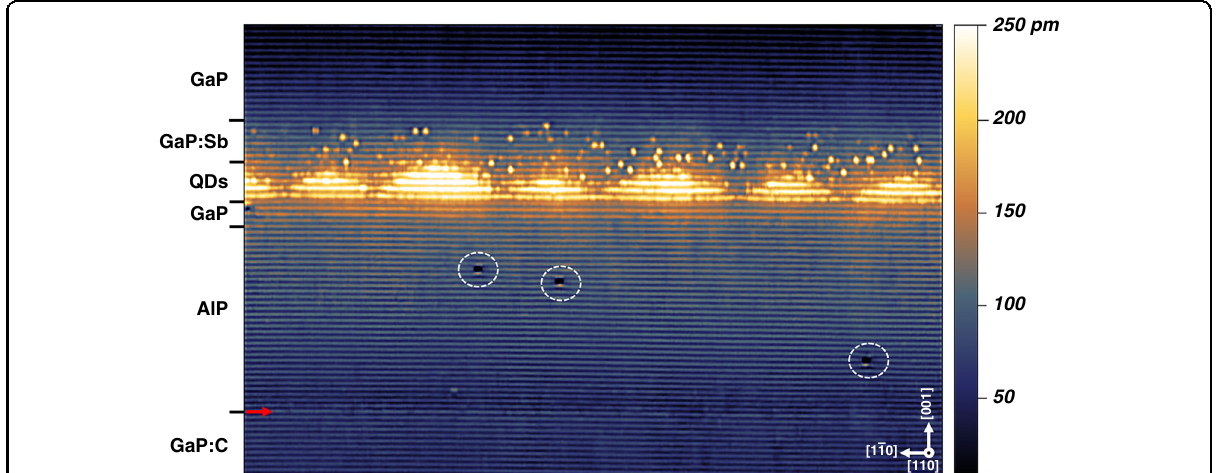
Fig. 1 A 60 × 40 nm 2 fi lled-state topographic image showing six full QDs taken at a bias voltage: V b = − 3.3 V and a tunnel current: I t = 50 pA. The red arrow indicates the interface between GaP:C and AlP; the white circles indicate “ P ” vacancies; the dark to bright contrast (250 pm) in the image represents the relative height of the STM tip from the surface as shown to the right of the image in the color bar. The white arrow indicates the growth direction